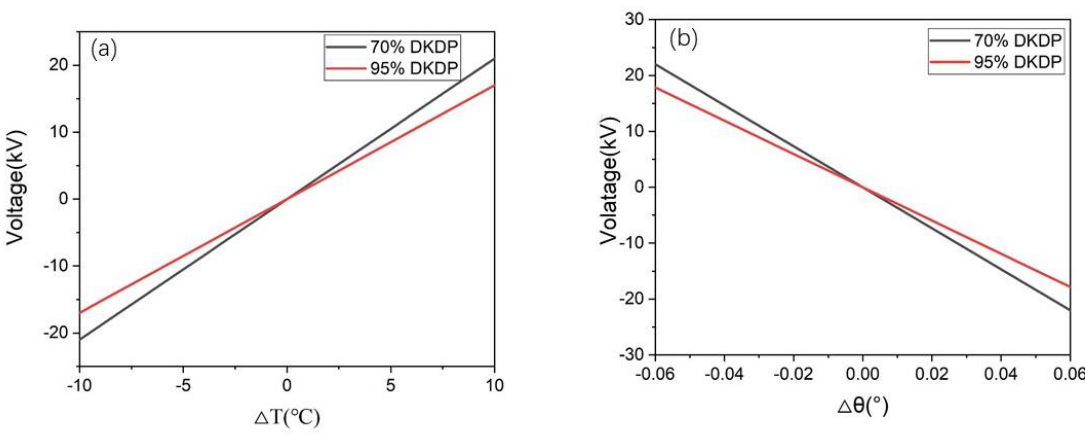
Figure 3. ( a ) Calculated phase mismatch compensation voltage versus temperature; ( b ) calculated phase mismatch compensation voltage versus angle.